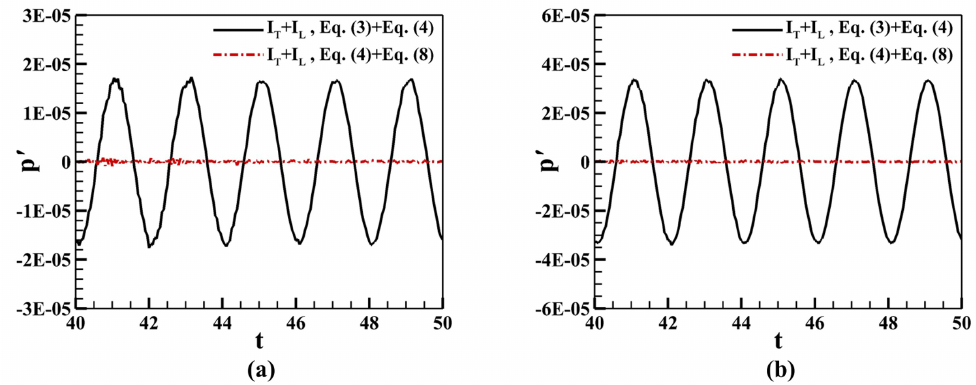
Figure 5. Comparison between the acoustic pressure with filtering the spurious mass flux (Equation (4) + Equation (8)) and without filtering the spurious mass flux (Equation (3) + Equation (4)) on the integral boundary corresponding to ( a ) A e = 10 − 5 m/s and ( b ) A e = 2 × 10 − 5